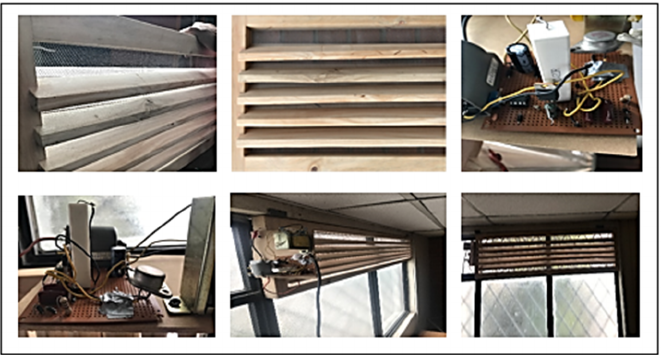
Figure 10. Prototype lattice construction.